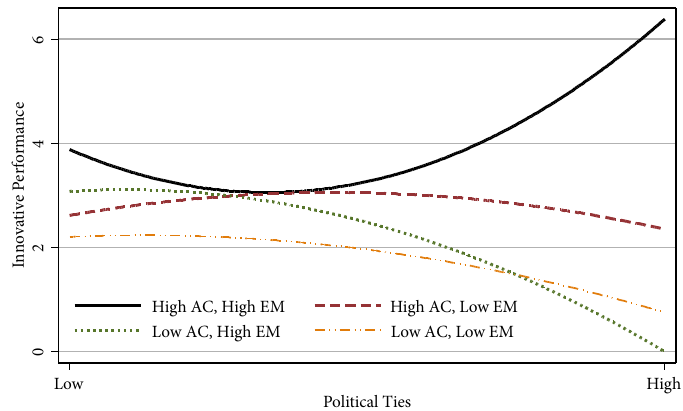
Figure 3. Curvilinear interaction of politic ties, absorptive capacity, and environmental munificence on corporate innovation performance